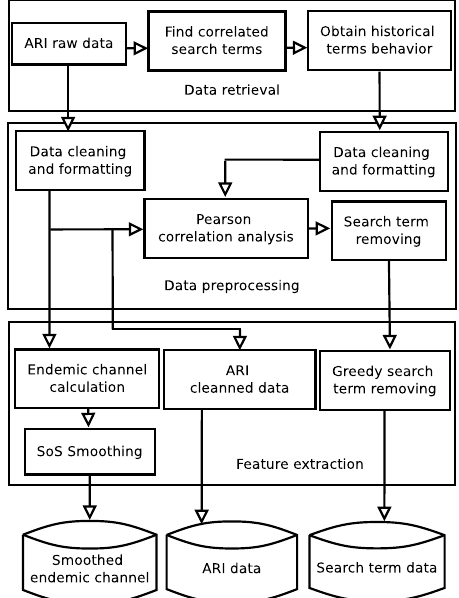
Figure 2. The Data acquisition stage is composed by three modules: Data retrieval, data preprocessing and feature